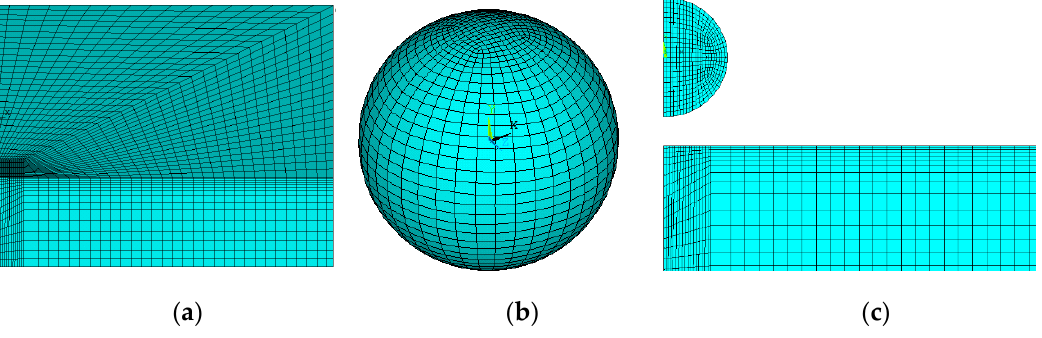
Figure 3. Mesh division during ball–plate collision: ( a ) matrix meshing, ( b ) ball meshing, ( c ) three- dimensional model of ball–plate collision.